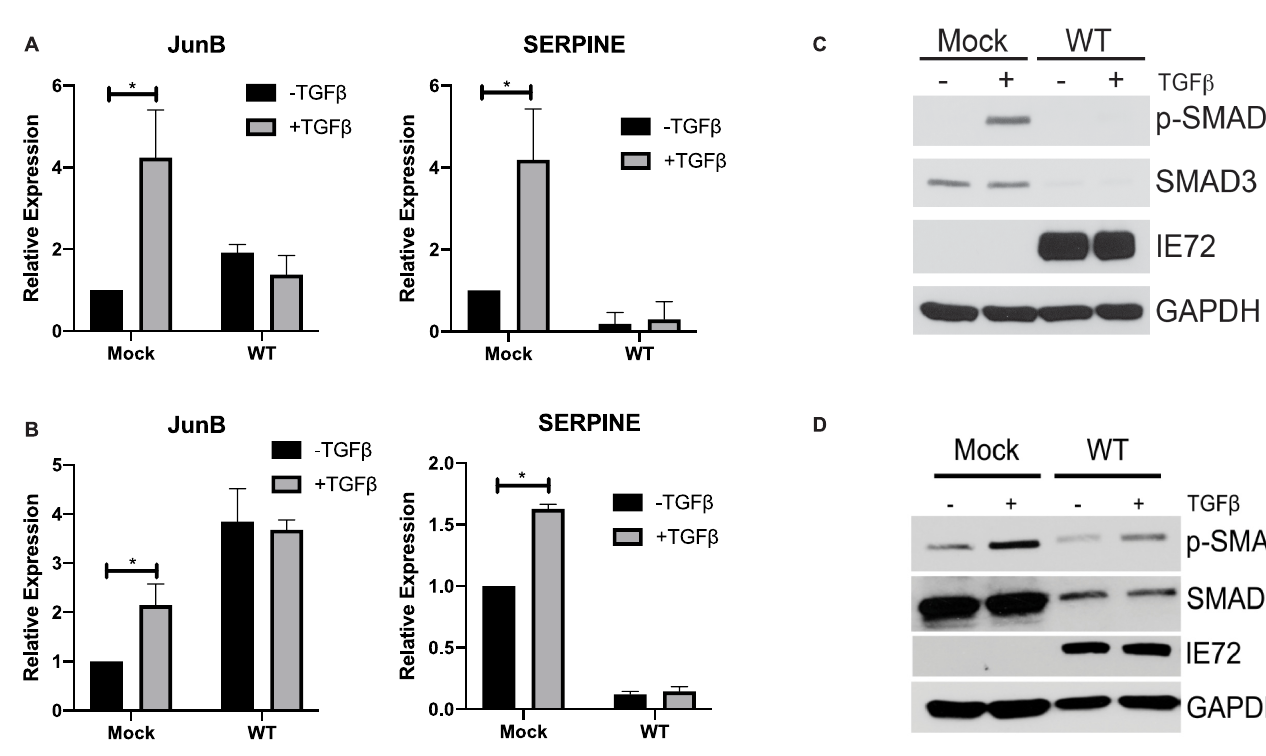
Fig 1. HCMV infection blocks canonical TGF β signaling. NHDF (A) of hAEC (B) were infected with WT TB40E for 48 hours, followed by overnight serum starvation and stimulation with recombinant TGF β (100pg/mL) for 4 hours. RNA was isolated and subjected to qRT-PCR for JunB and SERPINE. Experiments were performed in triplicate. � p < 0.05 by two tailed Student’s t test. NHDF (C) or hAEC (D) were infected as above and protein lysates subjected to immunoblotting using the indicated antibodies.